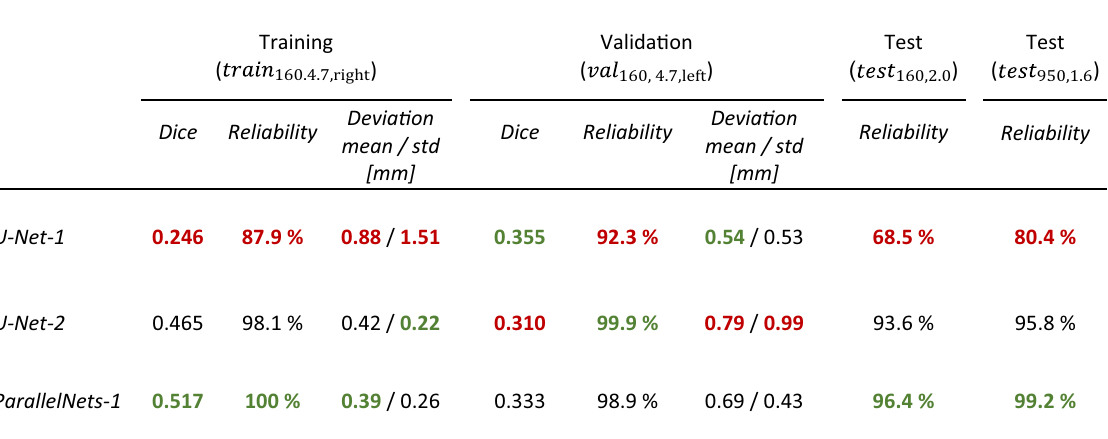
Table 1. Performance comparison of the three trained models on training, validation, and test datasets with respect to the Dice coefficient (higher is better), reliability (higher is better), and mean deviation from crack tip ground truth in millimeters (lower is